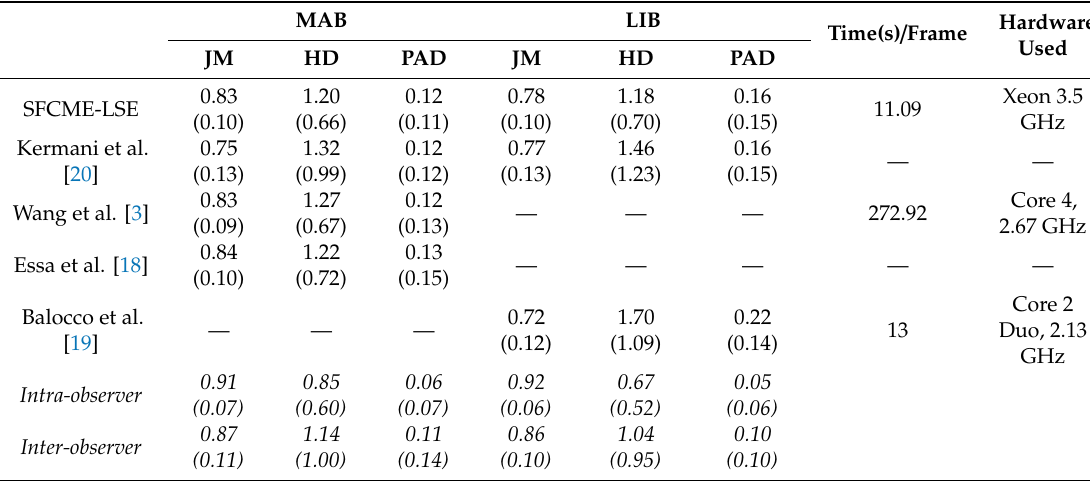
Table 4. Comparison of the proposed SFCME-LSE method with other published automatic methods. Empty cells mean that the researchers have not given the corresponding